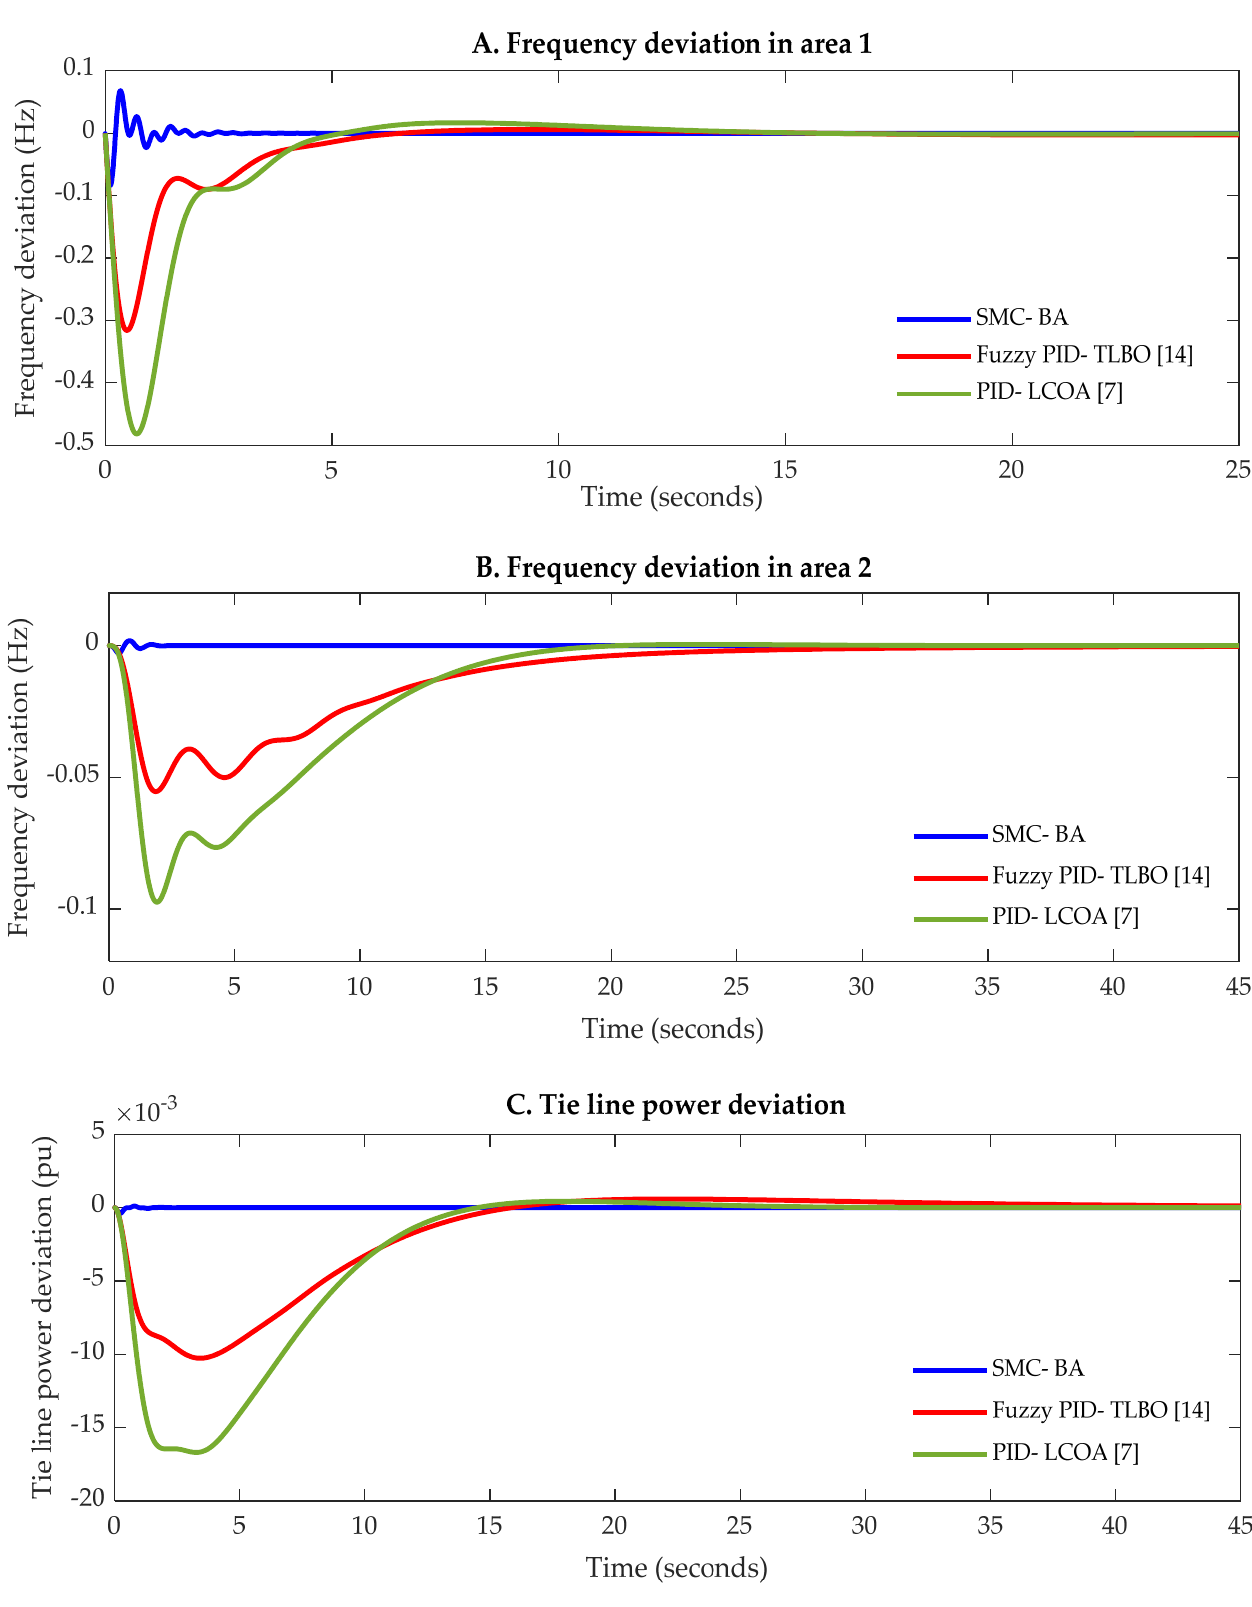
Figure 15. Dynamic response of the system with different controllers under parametric uncertainties, case 9. ( A ) Frequency deviation in area 1; ( B ) Frequency deviation in area 2; ( C ) Tie line power deviation.